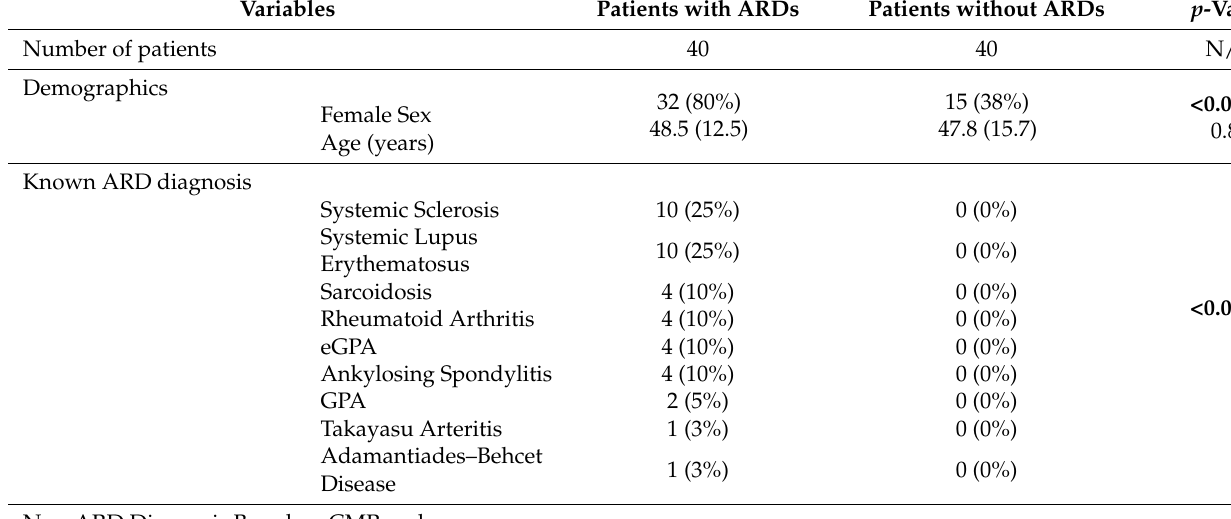
Table 1. Baseline characteristics compared between patients with NSVT and normal LVEF, with or without ARDs. * p ≤ 0.05. Variables Patients with ARDs Patients without ARDs p